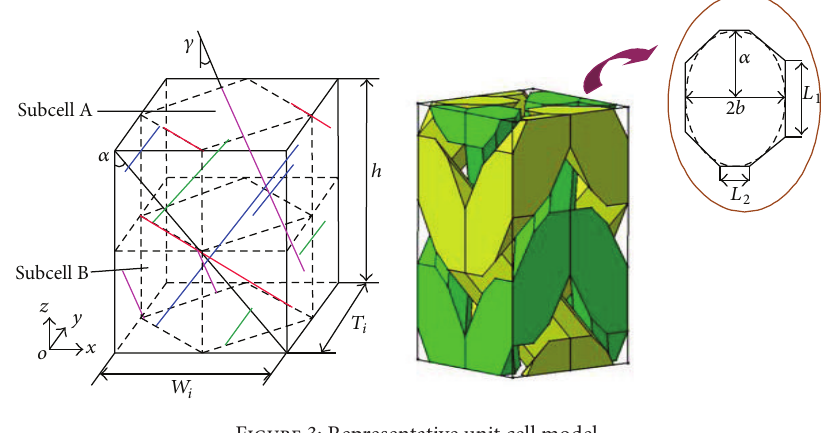
Figure 3: Representative unit cell